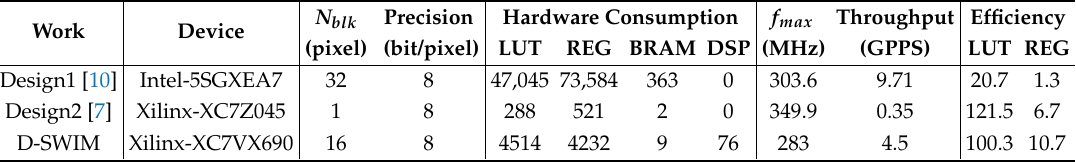
Table 5. Hardware resource consumption and throughput in a Conv2D implementation.